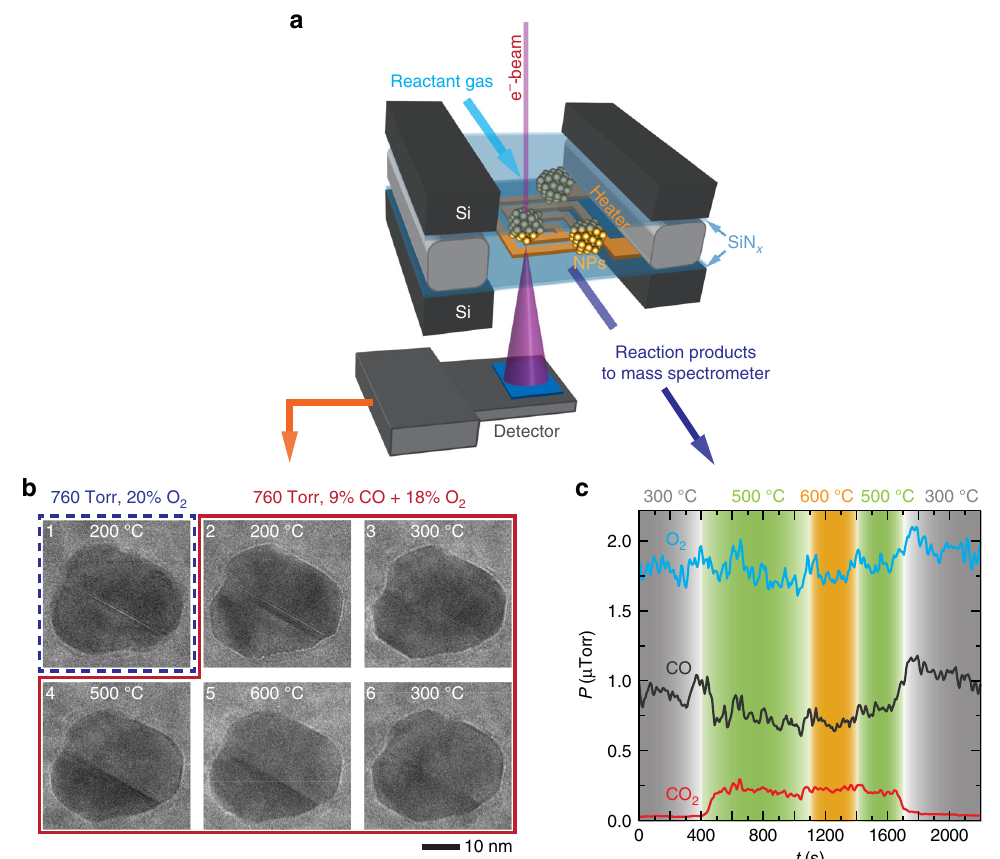
Fig. 1 Operando transmission electron microscopy (TEM) of Pd nanocatalysts during CO oxidation. a Schematic of the experimental setup where metal nanoparticles (NPs) are synthesized within a microfabrication gas cell with an integrated thin- fi lm heater. The reactant gases after passing over the catalysts are analyzed using an inline mass spectrometer. For enlarged images of panels 2, 5, and 6, see Supplementary Fig. 1a. b Sequence of TEM images of a Pd NP under different gas environments and temperatures. c Changes in gas composition (carrier gas is He) obtained from the inline mass spectrometer during temperature changes between 300 and 600 °C. These results correspond to panels 3 – 6 in the red box shown in b